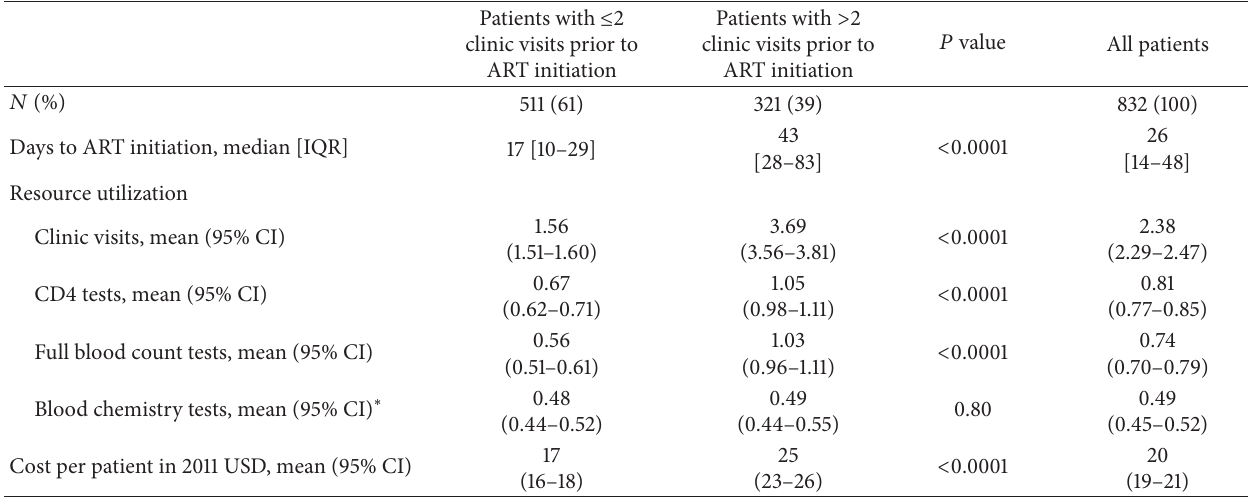
ART: antiretroviral therapy; USD: United States dollar. ∗ Abloodchemistrytestcouldincludeanycombinationofthefollowingtests:alanineaminotransferase,aspartateaminotransferase,creatinine,glucose,protein, urea, total bilirubin, and direct bilirubin